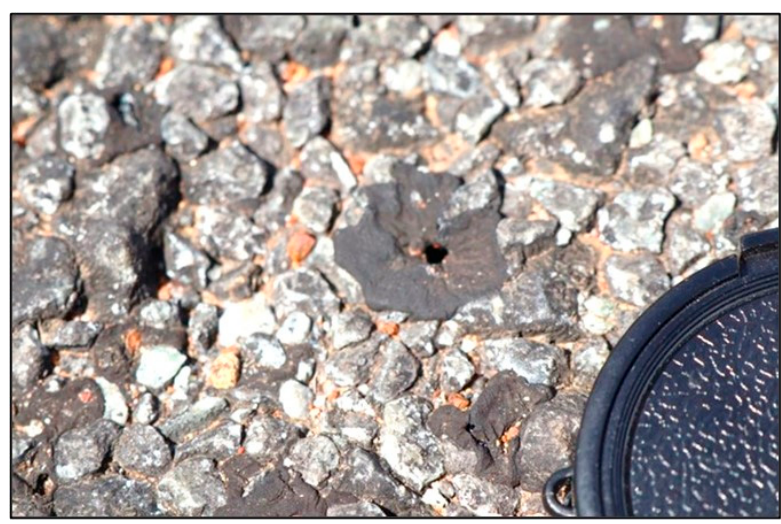
Figure 20. March 2020—condition of the double seal showing multiple holes all over the test section with excess binder on the top of the surfacing surrounding the holes.